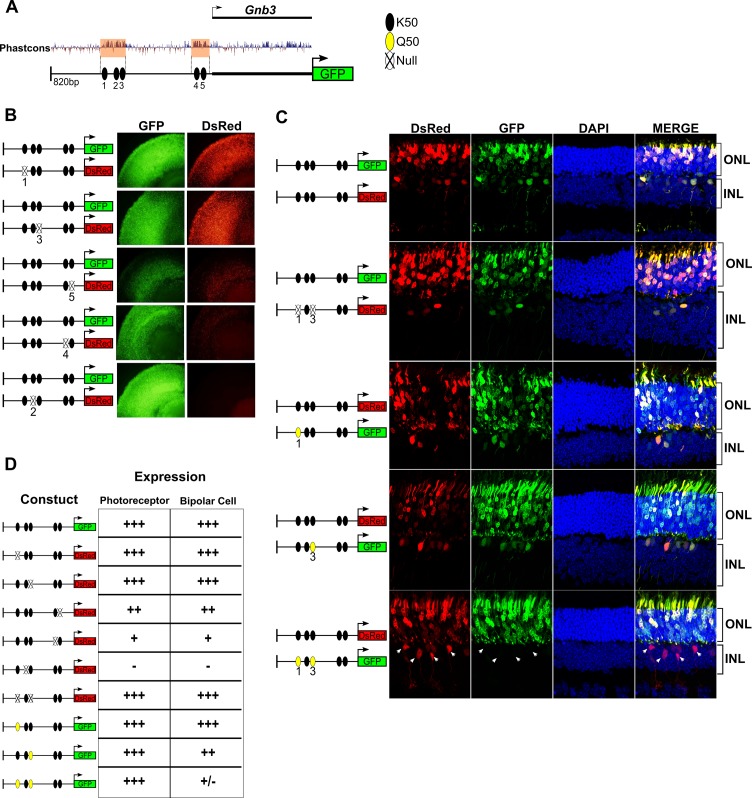
K50 motifs are required for expression in both photoreceptors and bipolar cells, while Q50 motifs mediate repression of reporter expression specifically in bipolar cells.(A) Schematic of reporter construct containing 820 bp from the promoter region and 5’ untranslated region (UTR) of mouse Gnb3. This region contains two phylogenetically conserved blocks harboring a total of five K50 motifs (black ellipses). (B) Left, Schematics of reporter pairs containing wild-type (WT; black) and inactivated (crossed out) K50 motifs. Right, Each pair of reporters was electroporated into explanted newborn mouse retina, which were subsequently harvested after eight days in culture and photographed in a flat mount preparation. While K50 sites 2, 4 and 5 are required for reporter expression, sites 1 and 3 are dispensable. (C) Left, Pairs of reporters containing WT, inactivated K50, or novel Q50 (TAATTA; yellow) motifs were electroporated into newborn mouse retina in vivo. After 20 days, the retinas of electroporated mice were harvested and photographed in vertical cross-sections. (C) Right, Representative cross-sections of retinas injected with the indicated pair of reporters. Loss of both K50 motifs 1 and 3 has no effect on expression in either photoreceptors or bipolar cells, while converting these same sites to Q50 motifs abrogates expression specifically in bipolar cells (n = 2–7 depending on reporter pair, Figure 6—source data 1). White arrowheads indicate bipolar cells expressing the WT reporter, but not the mutated one. (D) Table summarizing the results of reporter analysis presented in (B) and (C).
10.7554/eLife.48216.017Figure 6—source data 1.Additional images of Gnb3 reporter injections.Additional replicates from in vivo subretinal injection and electroporation of reporter pairs shown in Figure 6C. Schematics of each reporter pair are shown at the right of each panel, with WT (black), inactivated K50 (crossed out), and novel Q50 (yellow) motif sites shown as ellipses.